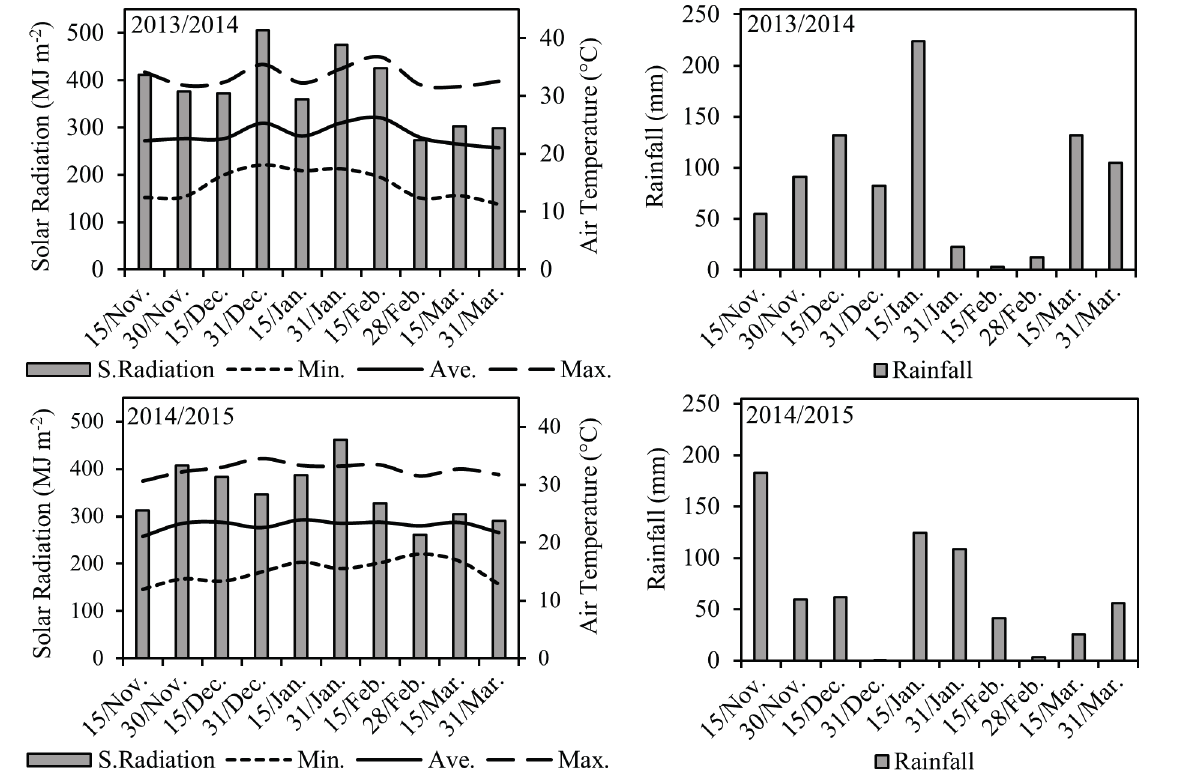
Figure 2 - Monthly average values of minimum, maximum and average temperature, accumulated incident solar radiation, and accumulated rainfall during the experimental period, in two crop years 2013/2014 and 2014/2015. Southern,